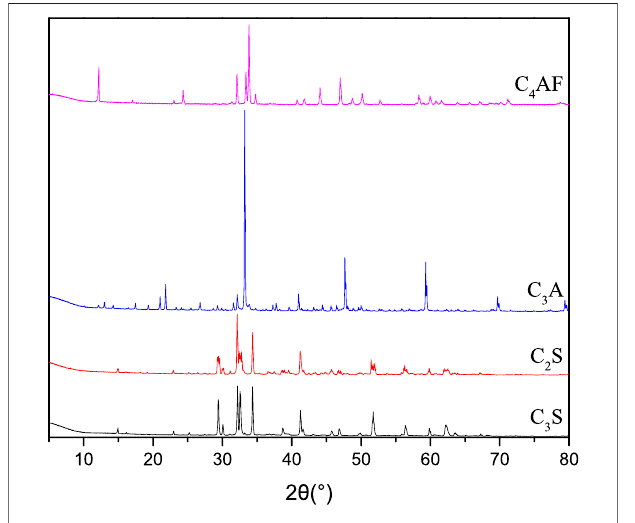
FIGURE 3 | Molecular weight distribution data.